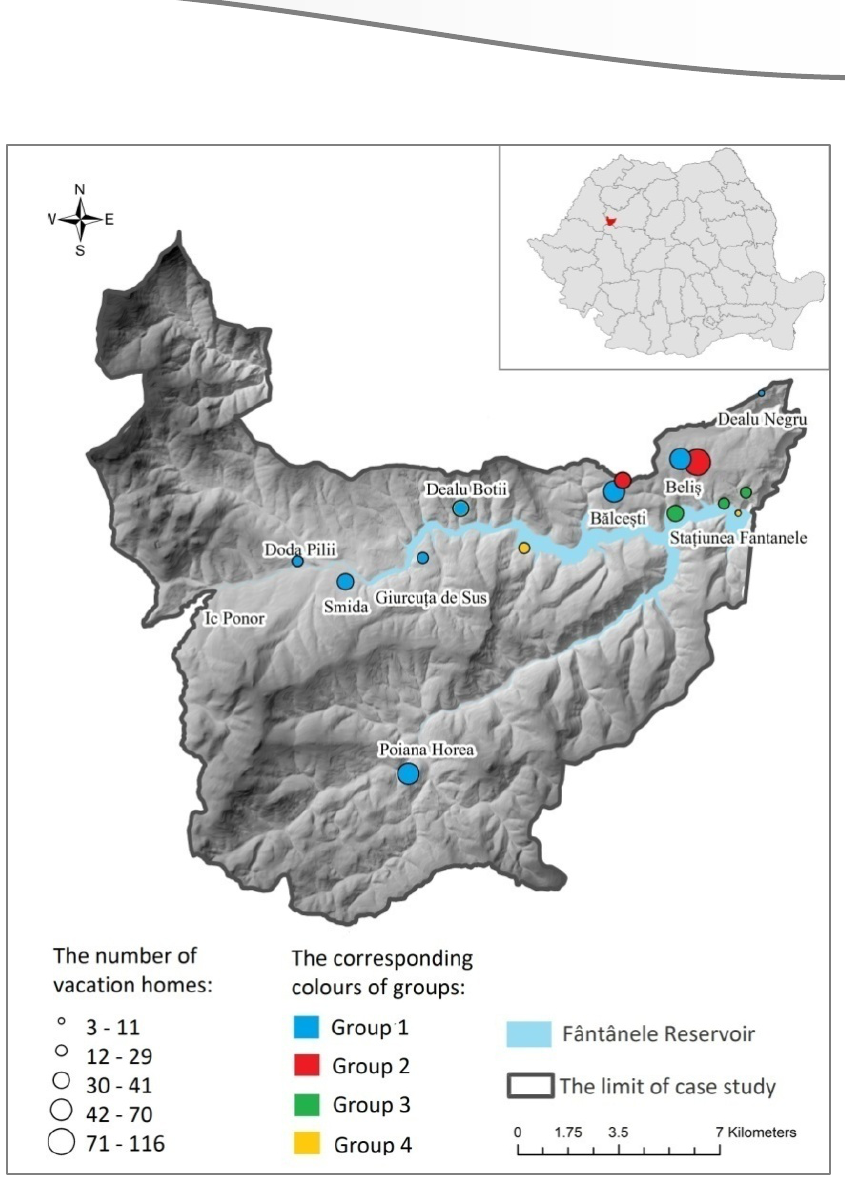
Figure 2: The spatial distribution of the grouping results in the case study of Apuseni Nature Park (part of Cluj